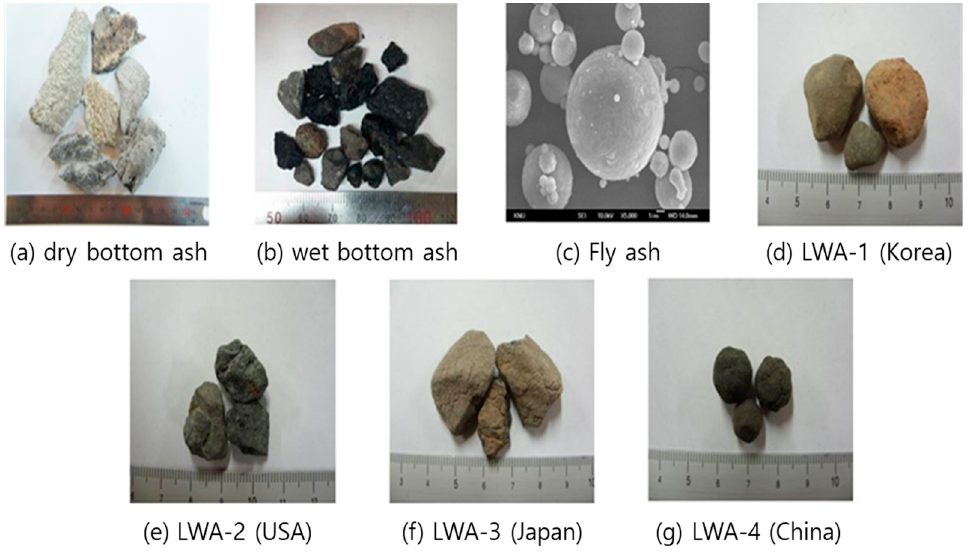
Figure 7. Shape of the test samples.